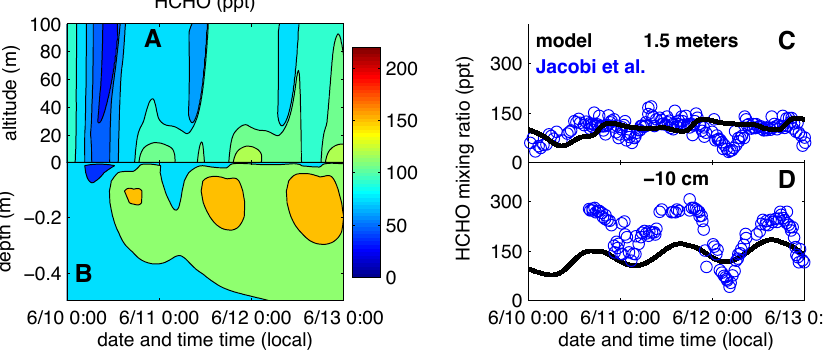
Fig. 8. Model predicted HCHO for the base case. Model results are compared with measurements taken in June 2000 originally published by Jacobi et al. (2004) ( c and d ). Measurements in the interstitial air during shading experiments have been removed from the comparison.